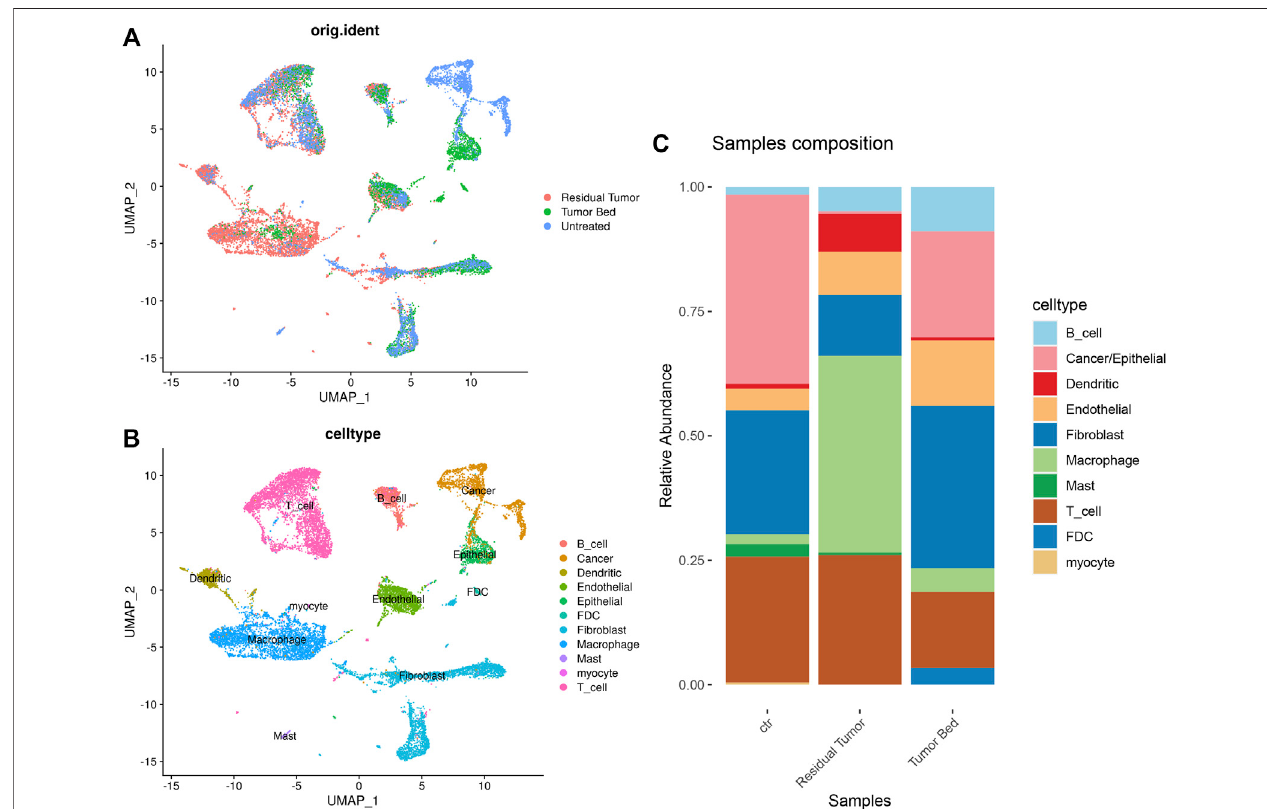
FIGURE3| Single-celltranscriptomicmapofmergeddataofOSCCsamplecontainingpost-chemotherapytumortissueandtreatmentnaïvetumor. (A) UMAPplot of original ident (from residual tumor, tumor bed or untreated tumor). (B) UMAP plot presentation of OSCC grouped by annotated cell types. (C) The composition of cell types shown in treatment naïve OSCC, residual tumor and tumor